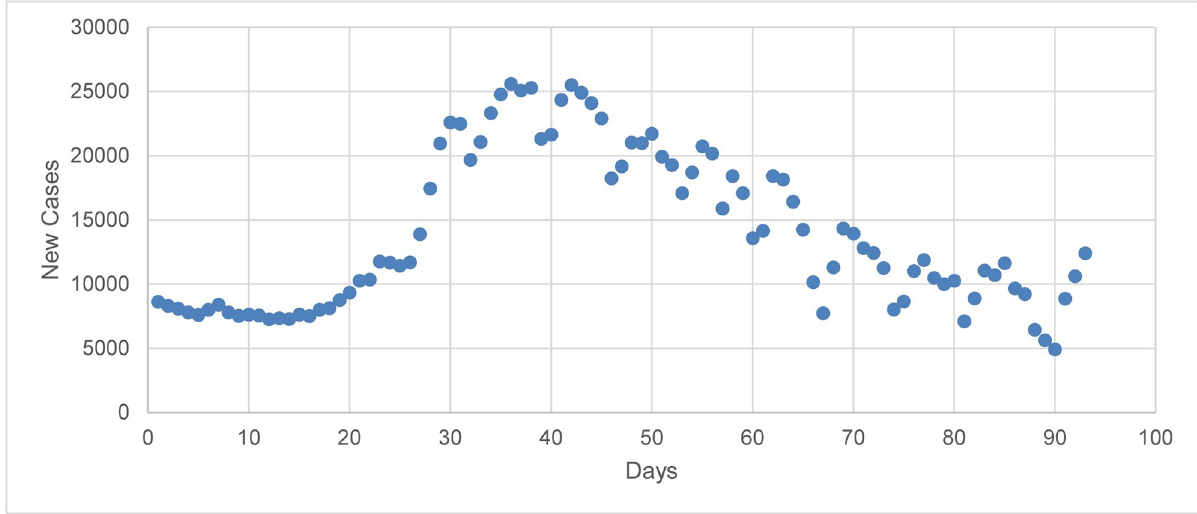
Fig 1. The number of daily infections for Alpha variant in